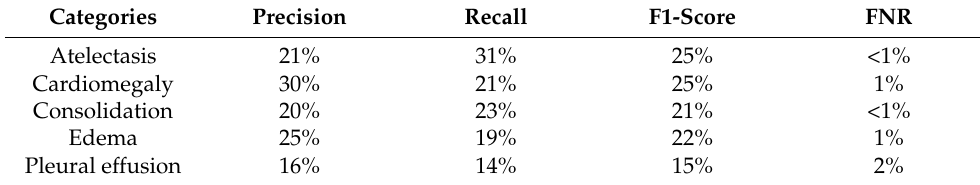
Table 5. Classification results for the testing